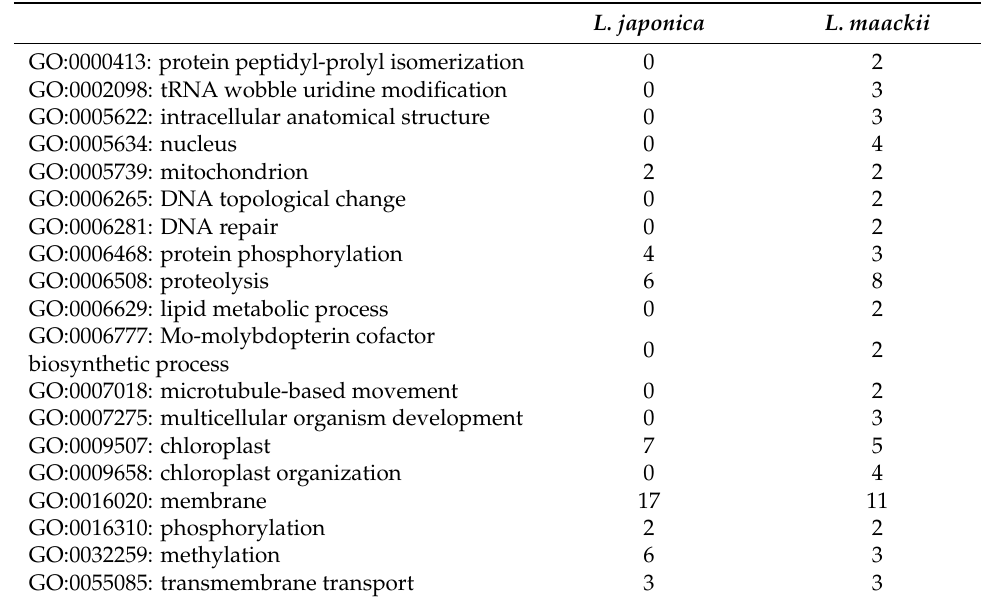
Table 3. Gene Ontology categories for missing BUSCOs in both the previously published L. japonica and the current L. maackii